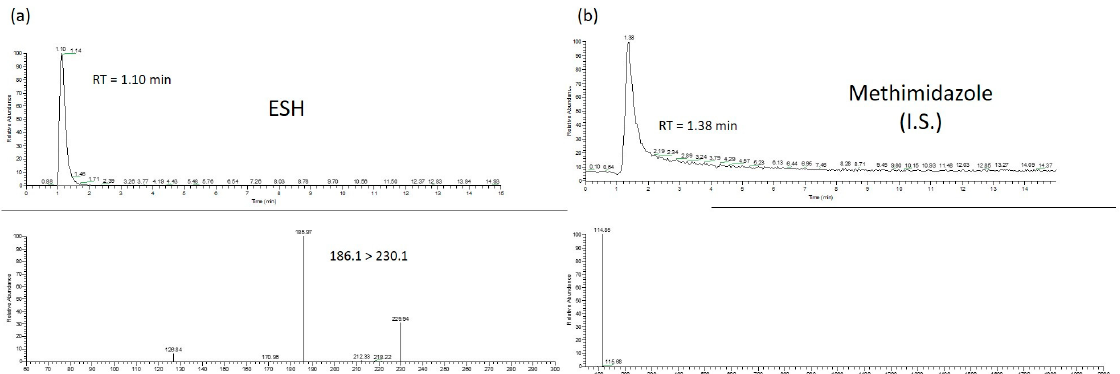
Figure 4. Representative chromatographs and mass spectra of Ergothioneine ( a ) and Methimidazole (internal standard) ( b ).